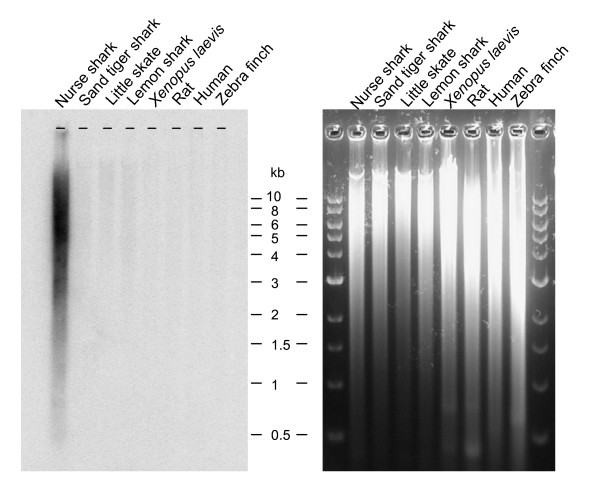
Southern blotting with the NSRE1 'overgo' probe. Genomic DNAs from various species (denoted at the top of the blot) were digested with Hin dIII and separated on an agarose gel. The 1 kb size standards were loaded on both sides of the gel. The ethidium bromide-stained image is shown as a loading control on the right of the blot.